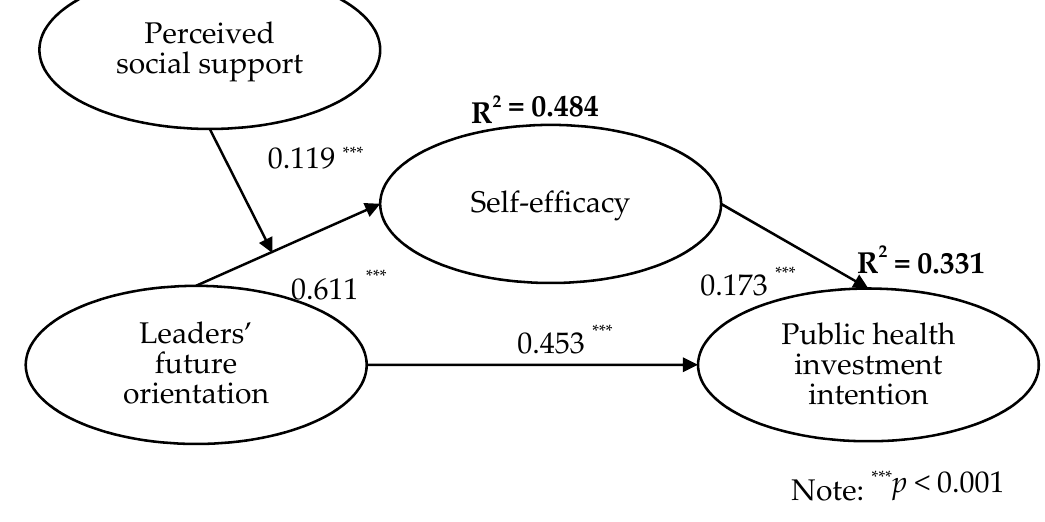
Figure 2. Hypothesis testing results.